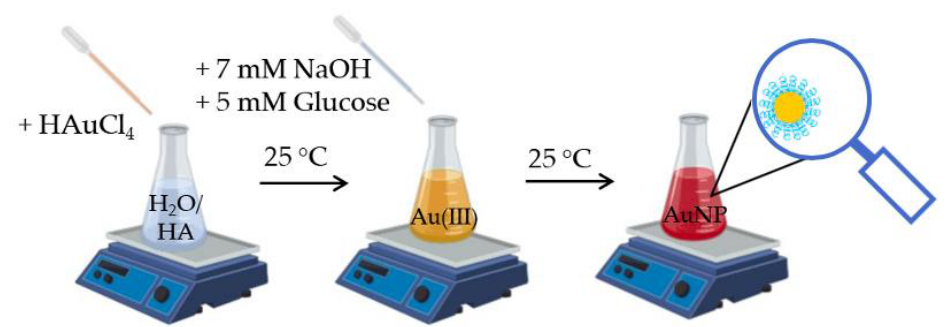
Figure 12. Schematic illustration of the synthesis of HA-capped AuNPs.